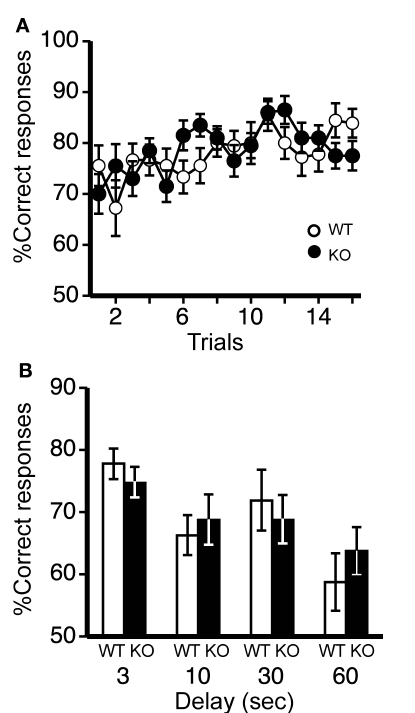
Figure 5 | No signifi cant differences in despair-like behavior between kf-1 + / + and kf-1 − / − mice in Porsolt forced swim test. (A) Immobility time Figure 7 | Spatial working memory in T-maze forced alternation = 0.886) and day 2 ( p = 0.1145, (%) in each block for day 1 ( p = 0.3525, F 1,38 task test. (A) No signifi cant differences were observed in spatial work- = 2.610). (B) Total distance (centimeters) traveled in each block for day F 1,38 ing memory between kf-1 + / + and kf-1 − / − mice as presented by % correct = 2.390) and day 2 ( p = 0.0435, F = 4.362). No sig- 1 ( p = 0.1304, F 1,38 1,38 = 0.258). (B) On the 17th to 20th trials, the responses ( p = 0.6146, F nifi cant differences were found between kf-1 + / + and kf-1 − / − mice, although 1,36 = 0.779), delay was applied after sample trial for 3 s ( p = 0.3829, F signifi cant reduction of distance traveled was barely observed in kf-1 − / − mice 1,36 = 0.226), 30 s ( p = 0.6267, F = 0.241), or 60 s 10 s ( p = 0.6371, F compared to kf-1 + / + littermates in day 2 (see Section ‘Porsolt forced swim 1,36 1,36 = 0.691). Data are given as mean ( ± SEM; see Section ( p = 0.4110, F test’). WT and KO stand for kf-1 + / + and kf-1 − / − mice, respectively. 1,36 ‘T-maze forced alternation task test’). WT and KO stand for kf-1 + / + and kf-1 − / − mice,